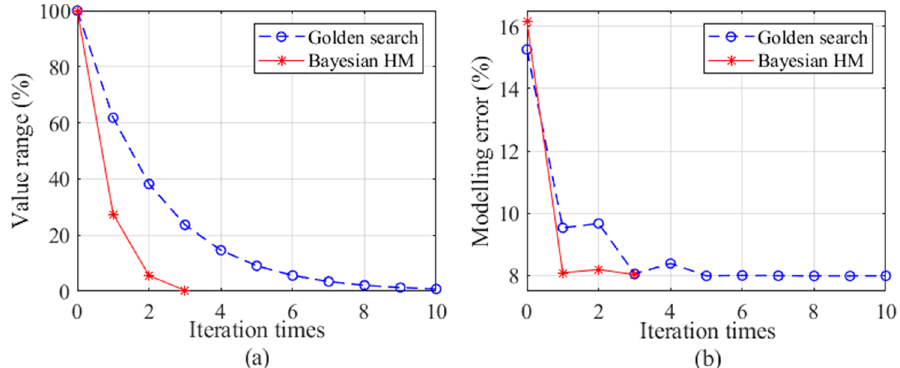
Figure 6. Comparison of BHM calibration method with traditional golden search method. (a) The reduction of value range; (b) the reduction of modelling error. Table 2. Calibration results of each iteration in single parameter calibration.